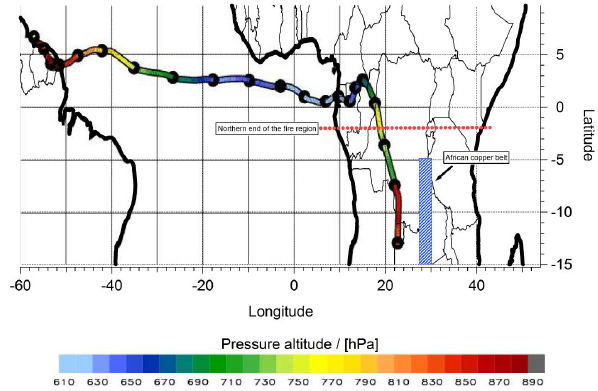
Fig. 3. Combination of the LAGRANTO 10-day back-trajectory starting at 13 August 2006 12:00 UTC with the LAGRANTO 10- day forward-trajectory starting at 13 August 2006 12:00 UTC. The color bar gives the air trajectory pressure. The red dots mark the northern edge of the fire region as shown in Fig. 1 and the blue area marks the so-called African copper